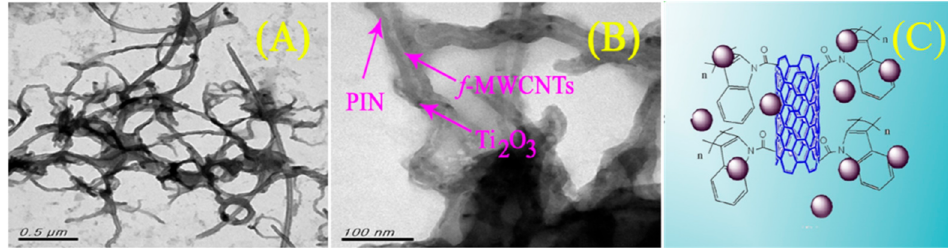
Figure 8. TEM images of an f-MWCNTs-PIN/Ti 2 O 3 nanocomposite ( A ), its detail ( B ), and illustration of the nanocomposite hybrid f-MWCNTs-PIN/Ti 2 O 3 /TiO 2 ( C ). Reproduced from [75] with the permission of